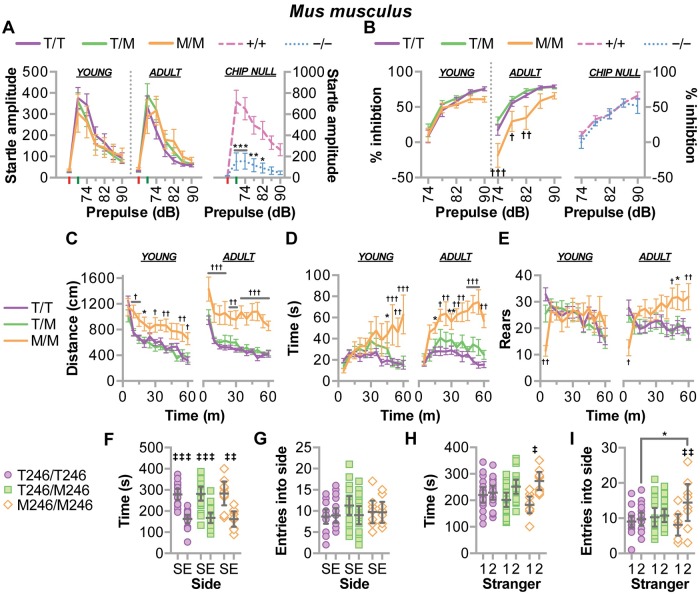
CHIP-T246M resulted in age-dependent deficits in sensorimotor skills, increased anxiety, and changes in sociability in mice.(A) The amplitude of startle response (red and green are no stimulus and acoustic startle stimulus alone trials, respectively) and (B) the amount of prepulse inhibition over increasing levels of sound, decibels (dB) in mice of the indicated genotypes. (C) The distance traveled, (D) time spent in the center, and (E) the number of rearing movements in open field test over time. Tests (A-E) were performed on mice with the indicated genotypes at 11–13 w of age (young) and repeated at 33 w of age (adult) and are represented by line plot and summarized by the mean ± SEM (N = 10–20 animals/genotype), Tukey’s post hoc test: *, ** correspond to p < 0.05, 0.01 comparing M/M to T/T (or +/+ to −/−); †, ††, ††† correspond to p < 0.05, 0.01, 0.001 comparing M/M to T/T and T/M; ‡ corresponds to p < 0.001 compared to the initial stimulus within the genotype (learning), ns = p > 0.05. (F) Time spent and (G) number of entries in either the side with stranger 1 (S) compared to an empty cage (E). (H) Time spent and (I) number of entries in either the side with previous stranger 1 (1) or novel stranger 2 (2). Tests F-I were performed on mice with the indicated genotypes represented by dot plot and summarized by the mean ± 95% CI (N = 10–20 animals/genotype), Tukey’s post hoc test: ‡, ‡‡, ‡‡‡ correspond to p < 0.05, 0.01, 0.001 within genotype; * p < 0.05 M/M vs. T/T.